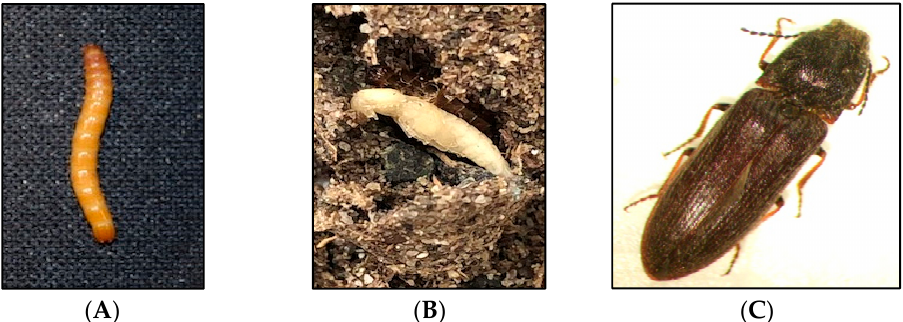
Figure 1. Different developmental stages of the click beetle, Limonius californicus : ( A ) late instar larva, ( B ) pupa, and ( C ) adult.